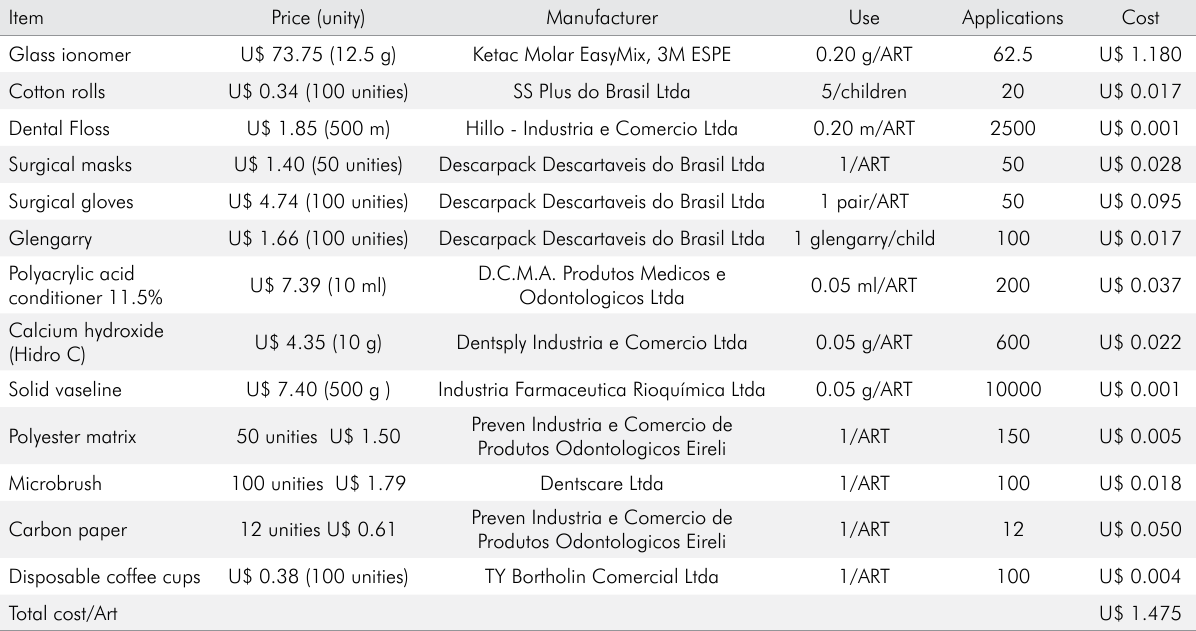
Table 2. Cost calculation for ART procedures using high-viscosity glass